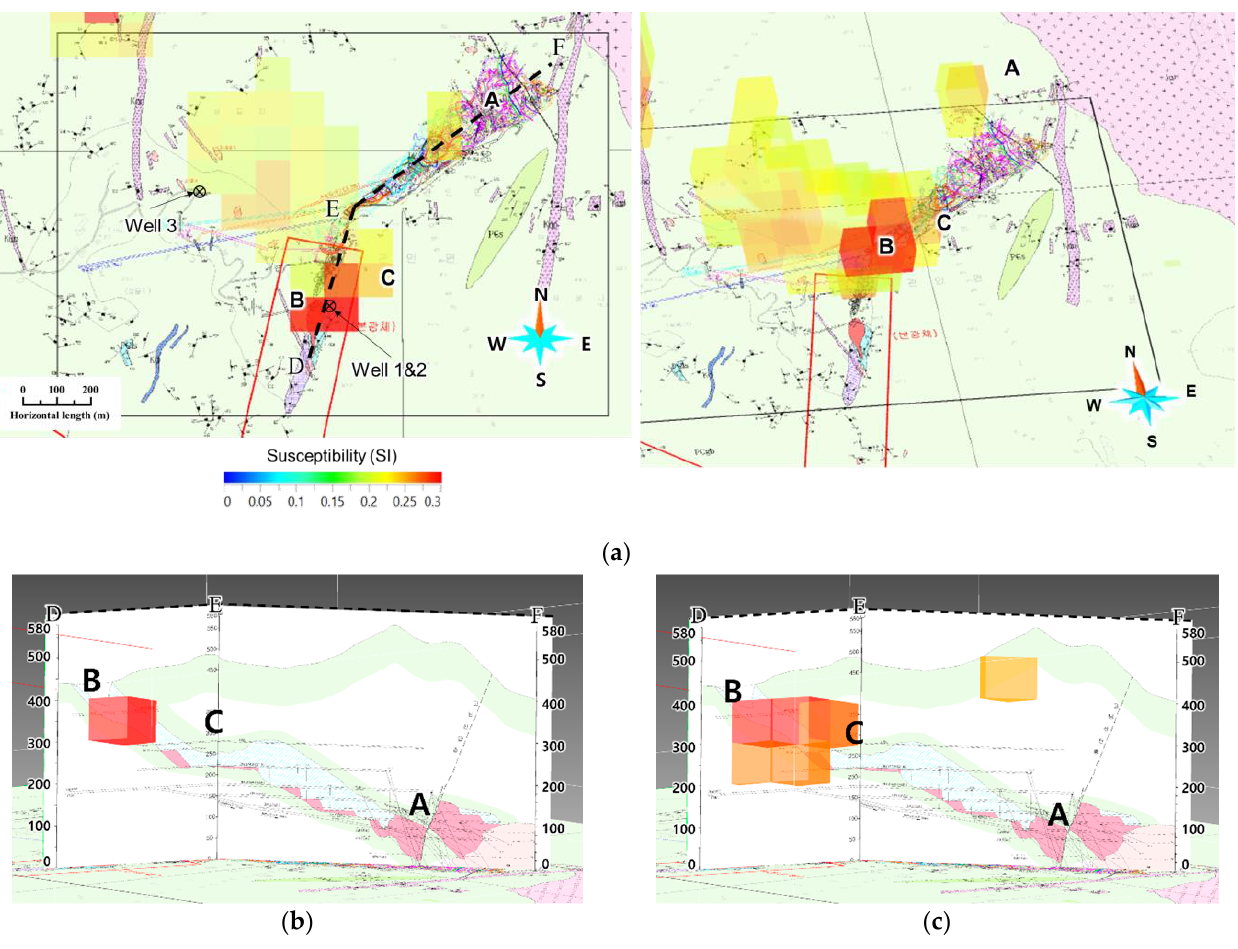
Figure 6. Inversion results of aeromagnetic data acquired using the helicopter system shown in Figure 3: ( a ) plan views showing only areas with susceptibility greater than 0.2, ( b ) side view showing only areas with susceptibility greater than 0.28, and ( c ) side view showing only areas with susceptibility greater than 0.25. The location of geological cross section shown in Figure 6b,c is indicated by dashed lines DE and EF in Figure 6a. The cross section shows the predicted distribution of potential iron ore (pink region) based on the position information of iron ore confirmed through drilling in the mine and the region developed so far.